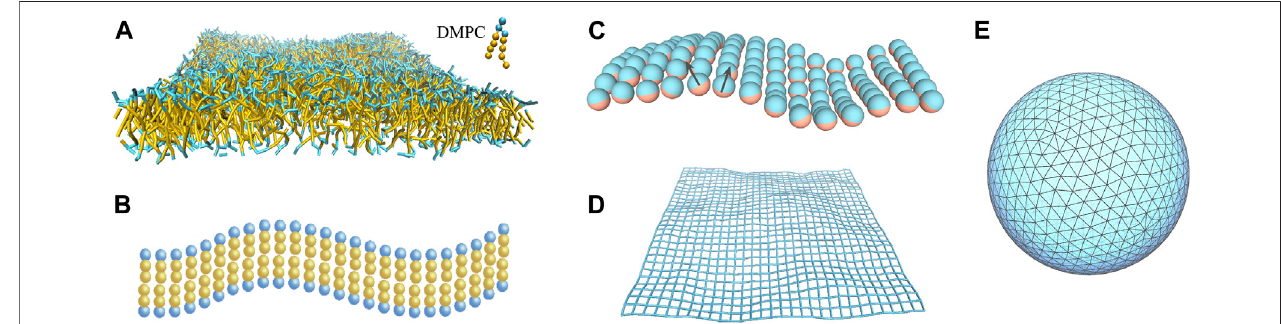
FIGURE 3 | Computational models for fl uid membranes at different levels of resolution. (A) Coarse-grained DMPC bilayer used in dissipative particle dynamics simulations. Watermolecules arenot shown herefor clarity. (B) Cooke-Deserno model (Cooke and Deserno, 2005)with each lipid consisting ofahydrophilicheadbead (inblue)andtwohydrophobictailbeads(inyellow).Stable fl uidbilayercanbesimulatedwithaproperchoiceoftail-tailattractionwithoutexplicitsolvent. (C) One-particle thick model (Yuan et al., 2010; Shiba and Noguchi, 2011). Any two particles experience short-range repulsion and long-range attraction. The particle-particle interaction depends on their orientations as speci fi ed by the normal vectors (black arrows). (D) Discretized elastic sheet model for a quasi-planar fl uid membrane (Weikl, 2001; Dommersnes and Fournier, 2002). The membrane con fi guration is described by the displacement fi eld h i with respect to the horizontal reference plane at each discrete site i . (E) Triangulated surface model for vesicular membranes (Kroll and Gompper, 1992; Sunil Kumar et al., 2001; Hu et al., 2011). The angle between the normal vectors of each two neighboring triangles determines the local curvature of the